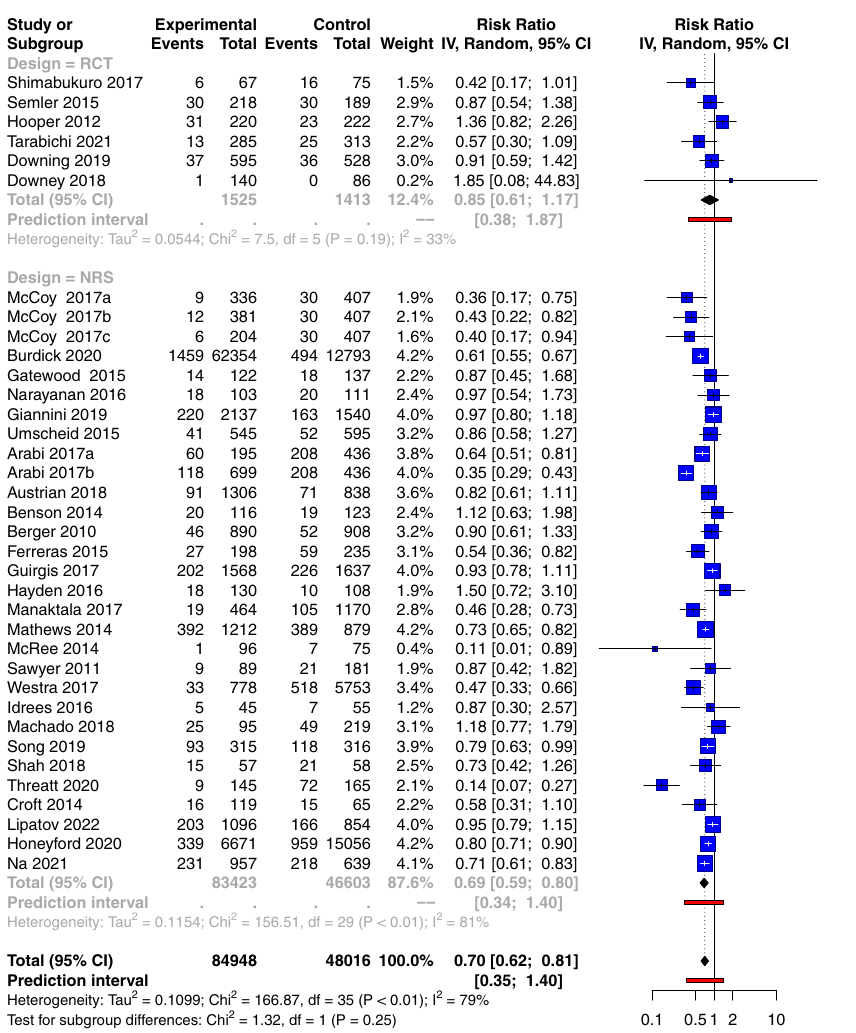
Fig. 5 Forest plot for pooled effects of the automated alerting system in mortality outcome. The size of the blue square indicates the weight of each study. The black diamond represents the pooled effect size for each subgroup as well as for the overall effect. The red bars represent the prediction interval. IV inverse variance, RCT randomized controlled trial, CI con fi dence